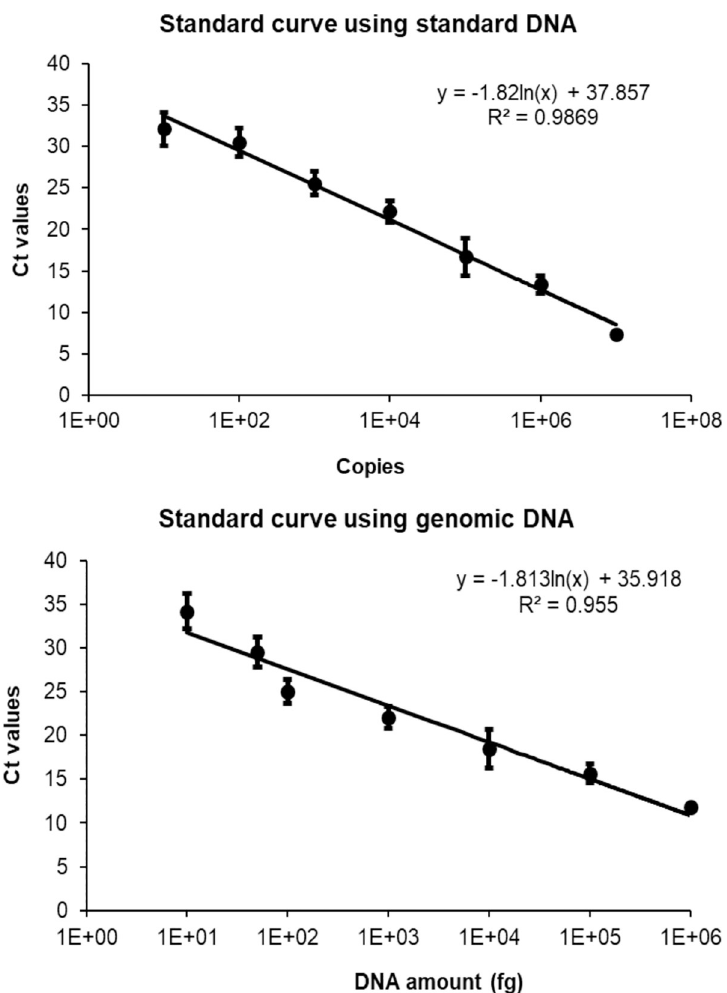
Fig 1. Detection limit of real-time PCR for WP_069098309.1 gene using pDNA and genomic DNA as templates. (A), Real-time PCR using serially diluted standard DNA standard with 10 7 to 10 1 copies per reaction; (B), Real-time PCR using serially diluted genomic DNA from 1 ng to 10 fg per